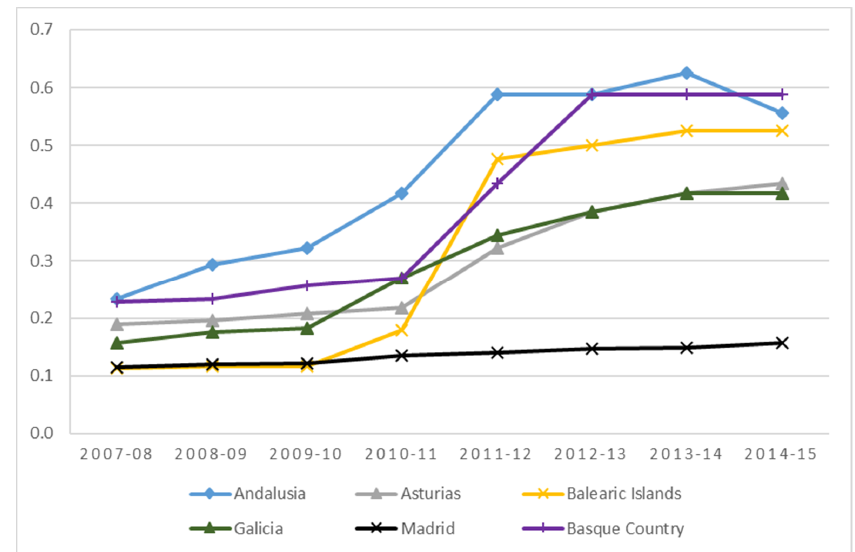
Figure 3. Evolution of the average number of computers used for teaching per student in public secondary schools in regions participating in Escuela 2.0 compared to Madrid. Source: Own elaboration based on data from the Spanish Ministry of Education.